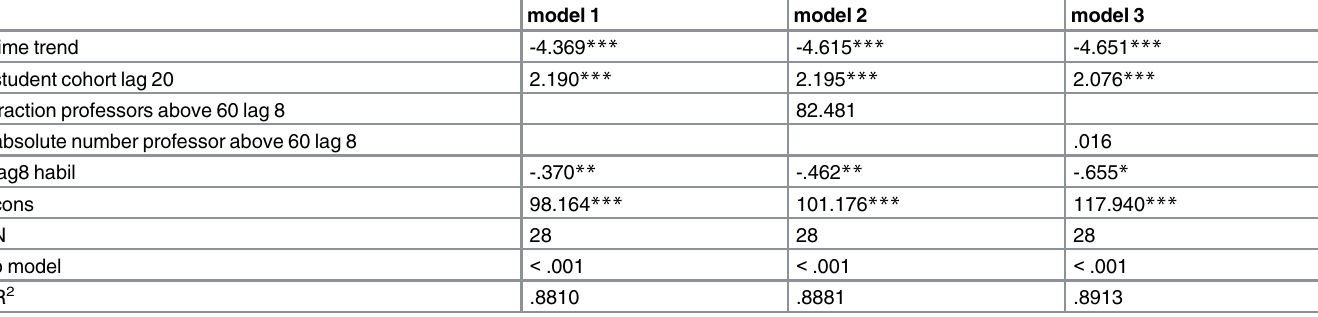
Table 4. Adding a Proxy for Available Positions in